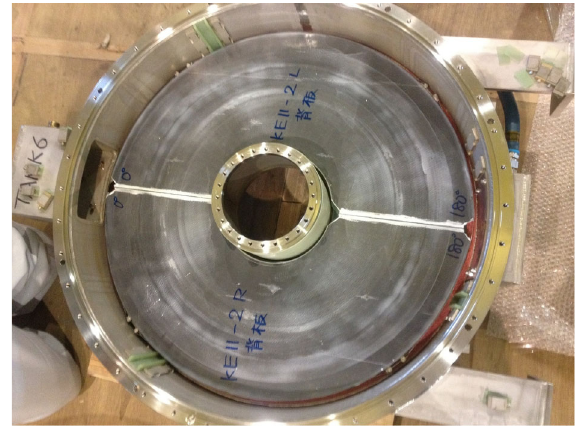
FIG. 7. The FT3L cut core is installed in a water